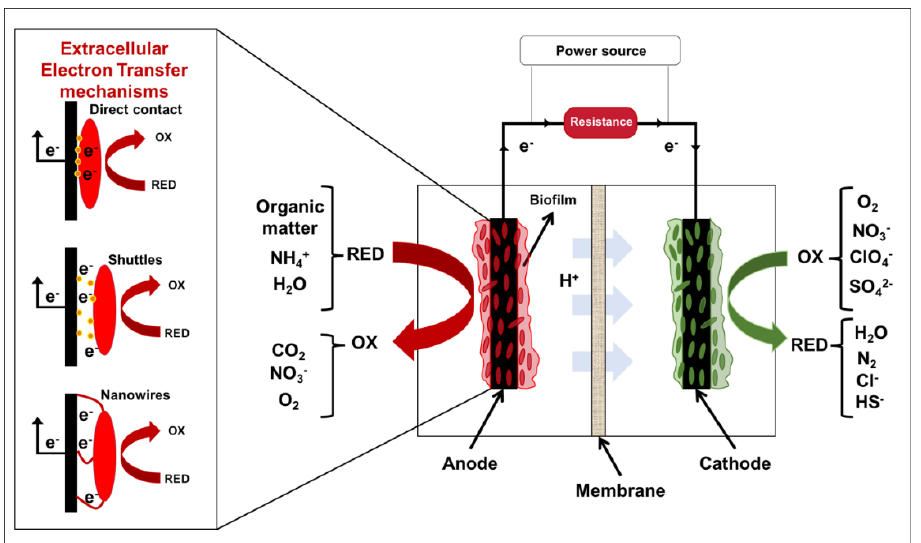
Figure 3. Illustration of the operation of a MET. OX: oxidized compounds, RED: compounds reduced (Modified from [68]).